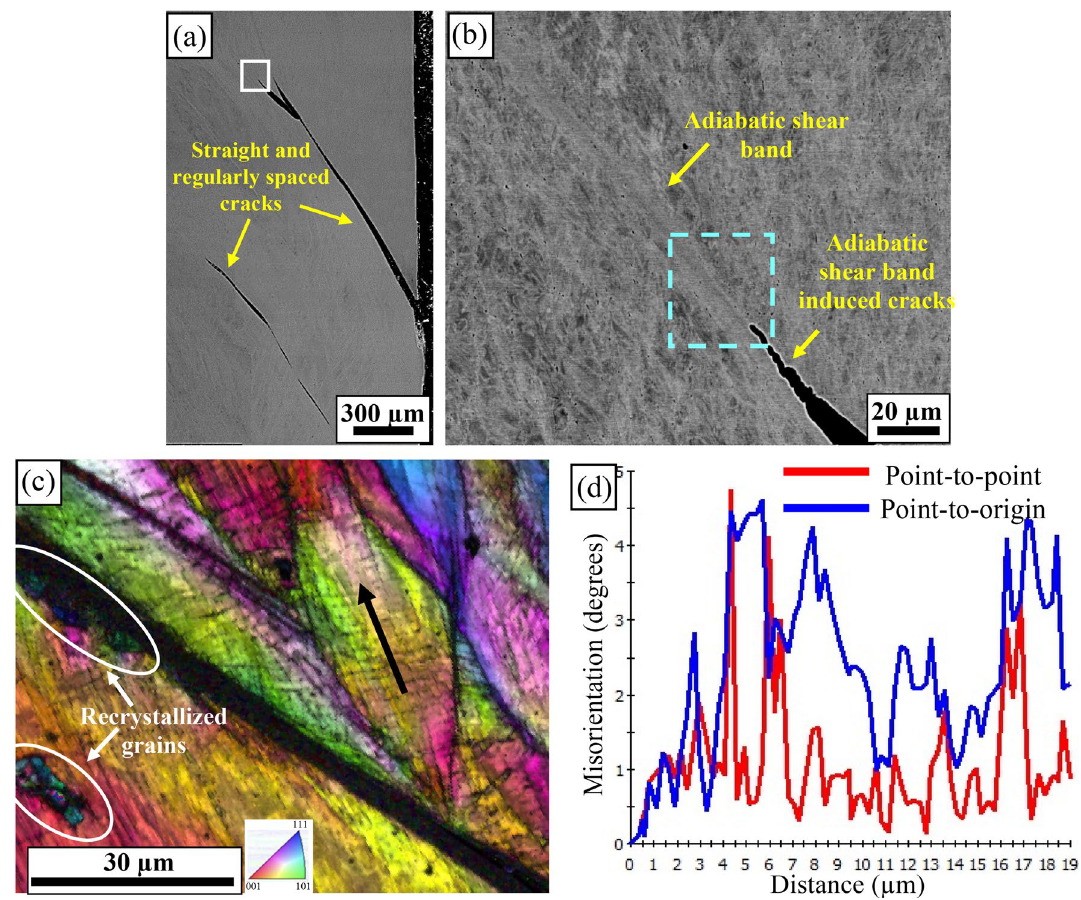
Figure 7. Microstructural characterization after high velocity ballistic impact of 1465 m/s: ( a ) low magnification SEM image showing parallelly propagating cracks and ( b ) backscattered SEM image of region shown with a white box in ( a ) shows ASBs and ASB induced crack; ( c ) IPF + IQ image of region shown with dotted box indicates recrystallized grains near the ASB and high density of microbands in the deformed grains; ( d ) misorientation profile of microbands along the black arrow shown in ( c ) indicates an average misorientation of ~ 3–4